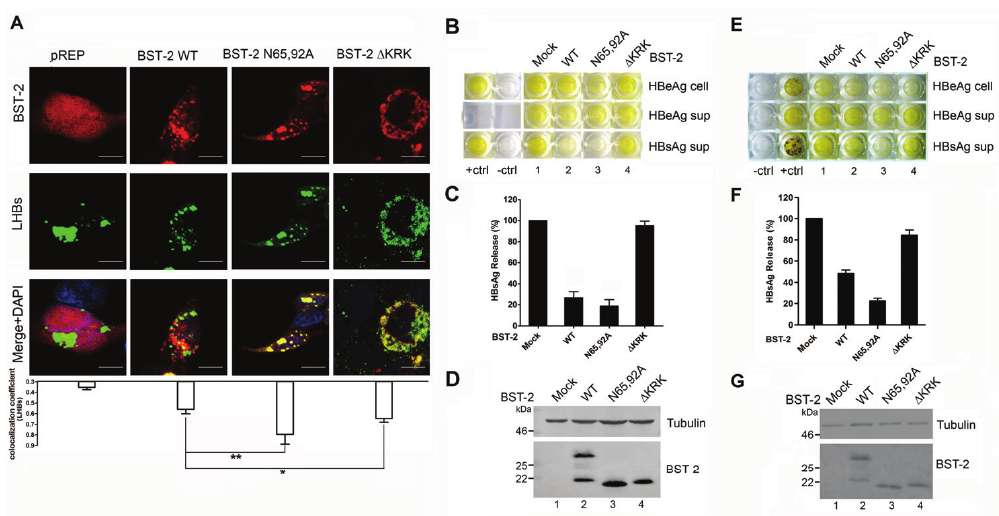
Figure 4. BST-2 with mutated glycosylation sites significantly co-localizes with LHBs and potently inhibits HBV production. ( A ) 293T cells transfected with 1 µ g of LHBs-Flag along with 800 ng of BST-2 or its variants or pRFP vectors were stained; blue, cell nucleus; green, LHBs protein; red, BST-2 protein. Images were taken under a Zeiss LZM710 confocal microscope. At least 30 individual cells were examined in each sample, and the most representative cells are shown. The co-localization coefficient (R) was calculated using Image-Pro Plus 6.0. Results were shown as mean ˘ SD. Statistical comparisons between the groups were performed by unpaired t-test using GraphPad Prism 5. ** p < 0.01, * p < 0.05. Scale bars = 10 µ m; ( B ) 293T cells were co-transfected with 50 ng of BST-2 or its variants along with 1 µ g of HBV proviral plasmid. HBV antigens in the cells and supernatants (sup) were detected by HBV antigen ELISA; ( C ) HBsAg release percentages of ( B ) are shown in columns; ( D ) BST-2 expression was detected by Western blotting; ( E ) Huh7 cells were co-transfected with 150 ng of BST-2 or its variants along with 1 µ g of HBV proviral plasmid. HBV antigens in the cells and supernatants (sup) were detected by HBV antigen ELISA; ( F ) HBsAg release percentages of ( E ) are shown in columns; ( G ) BST-2 expression was detected by Western blotting.